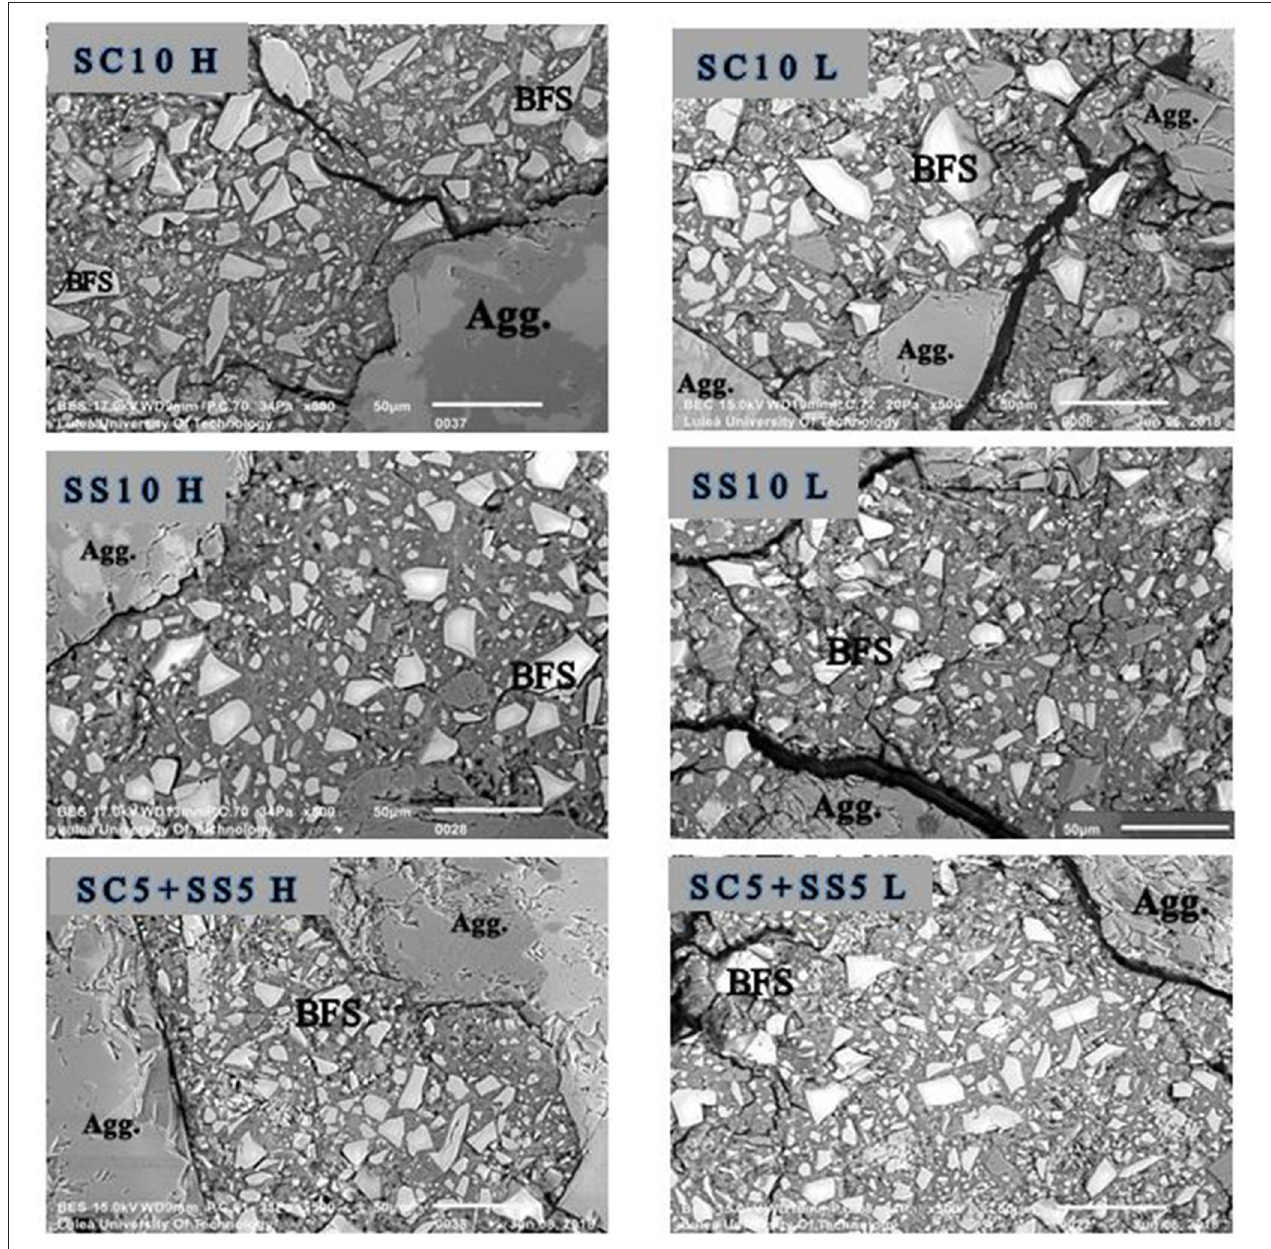
FIGURE 9 | Efflorescence of lab-cured samples when de-molded at early age and left open in a laboratory environment for 2–3h.